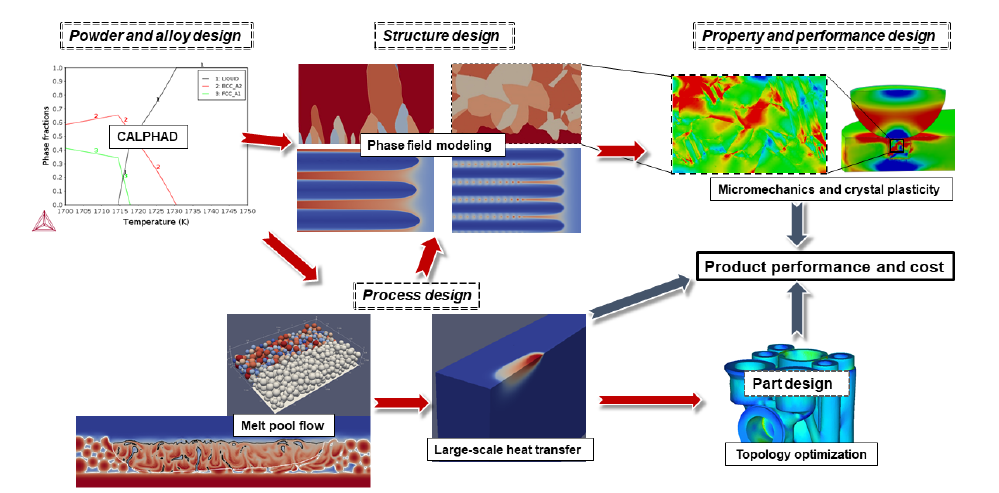
Figure 1. Integrated computational materials design (ICME) framework for metal additive manufacturing. The arrows show the direction of information transfer across the